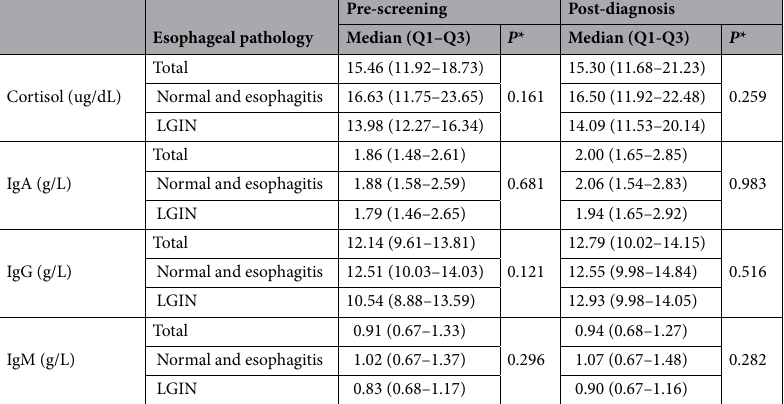
Table 1. Cortisol and immunoglobulin levels among participants with different esophageal pathology grades. Esophageal pathology: Normal (n = 23), Esophagitis (n = 8), LGIN (n = 30). Q1 lower quartile (25%), Q3 upper quartile (75%), LGIN Low-grade intraepithelial neoplasia. *Mann–Whitney U test.